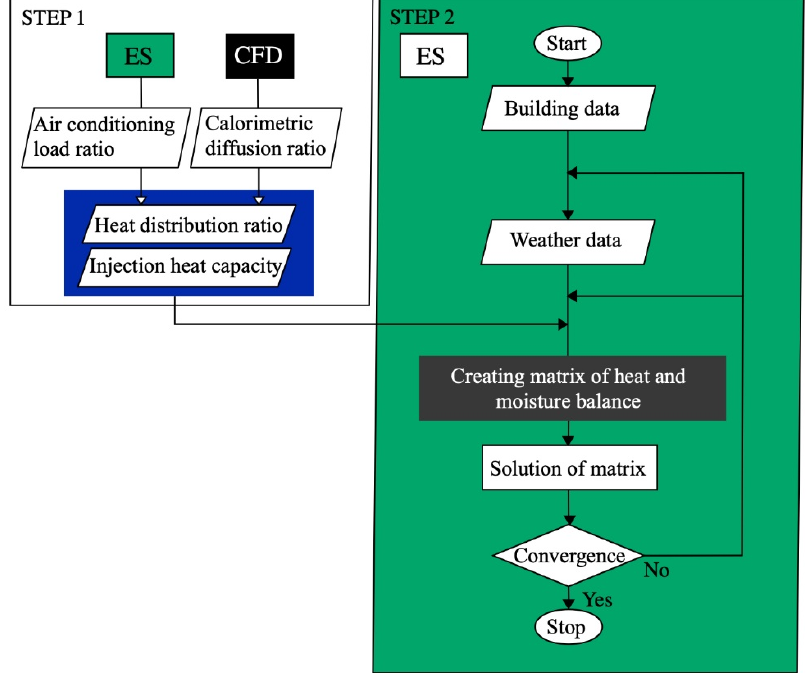
Figure 1. Coupled flow of the proposed method. ES, energy simulation; CFD, computational fluid dynamics.